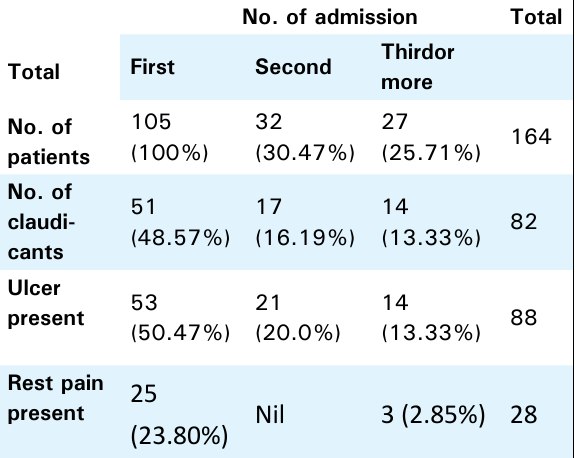
table 5. Distribution of clinical